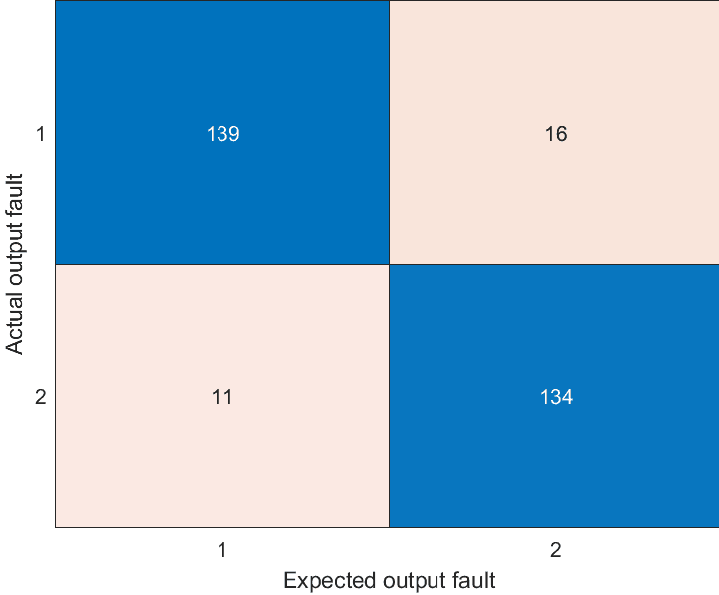
Figure 11. Classification confusion matrix diagram of fault diagnosis.